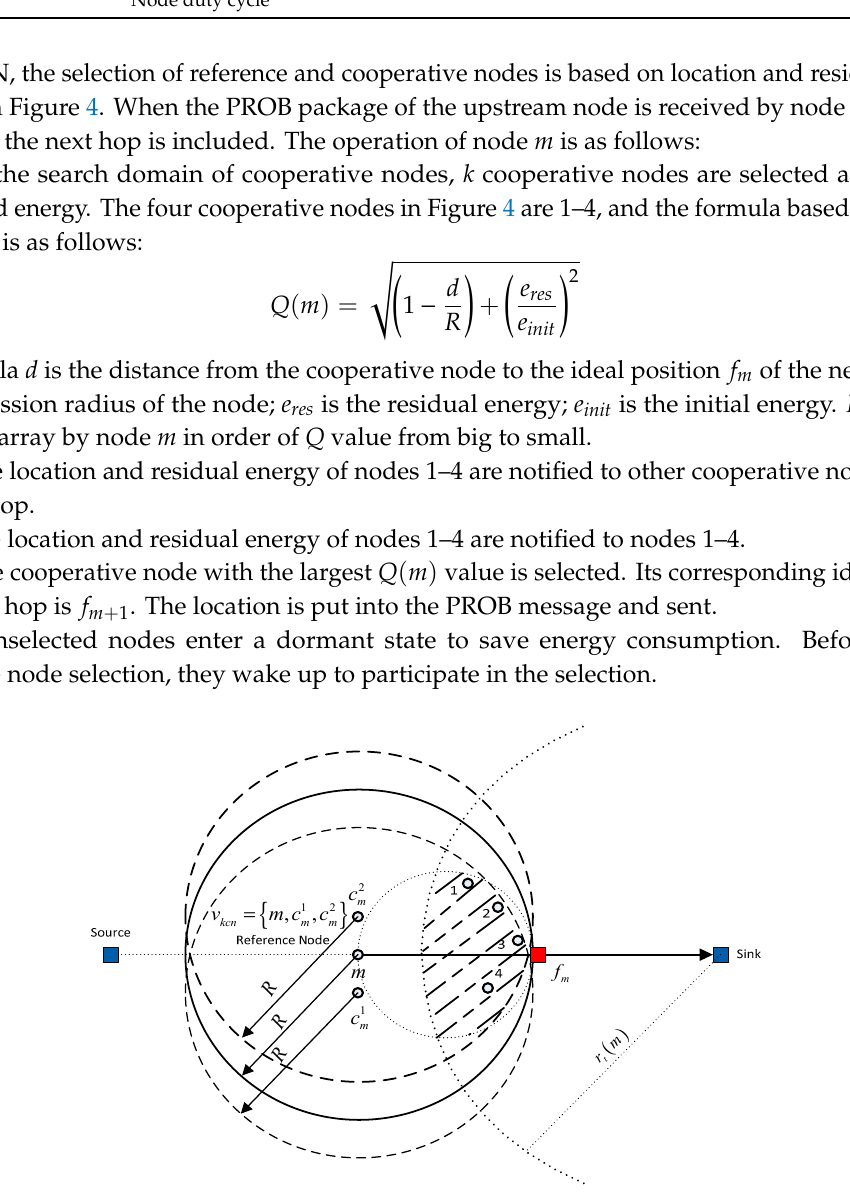
Figure 4. Selection of collaboration nodes.